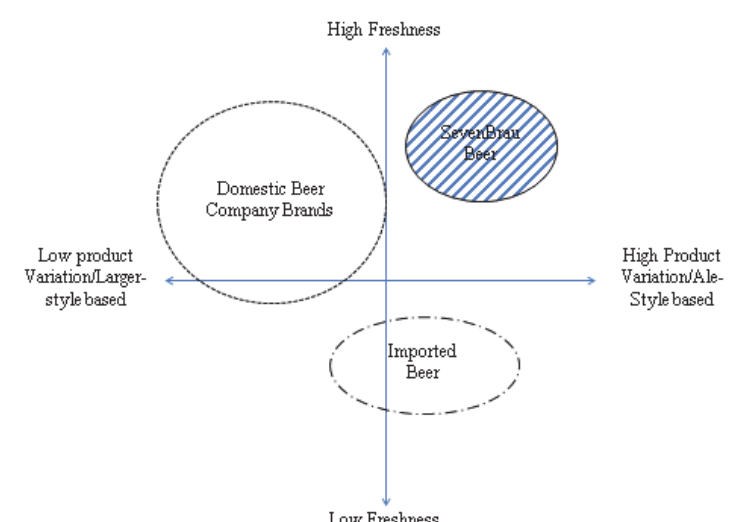
<Figure 1> Positioning Map of SevenBr ä u